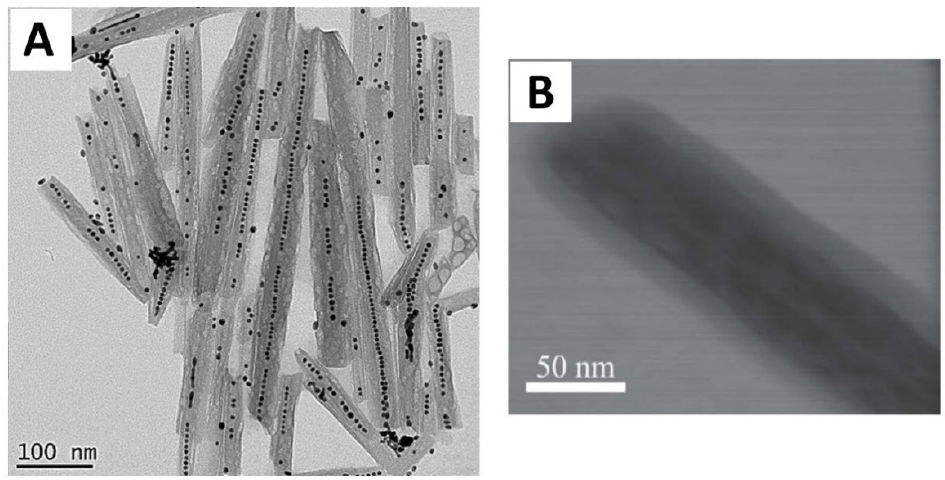
Figure 7. ( A ) an example of “bubbling” of HNTs under electron beam. Reprinted with permission from Ref. [132]. Copyright 2017 American Chemical Society, ( B ) example of TEM image shading due to organics degradation. Reproduced from Ref. [85] with permission from the Royal Society of Chemistry.